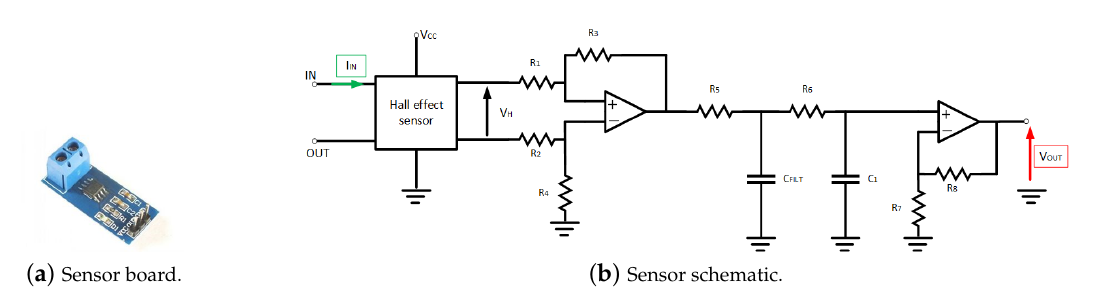
Figure 2. Adopted voltage sensor.